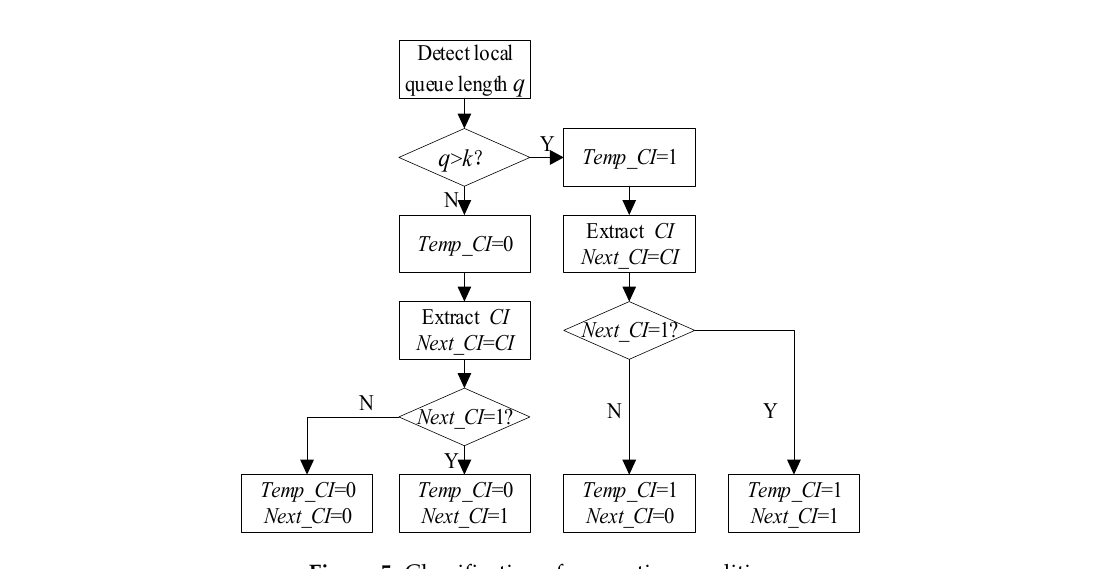
Figure 4. Modified ACK frame format.